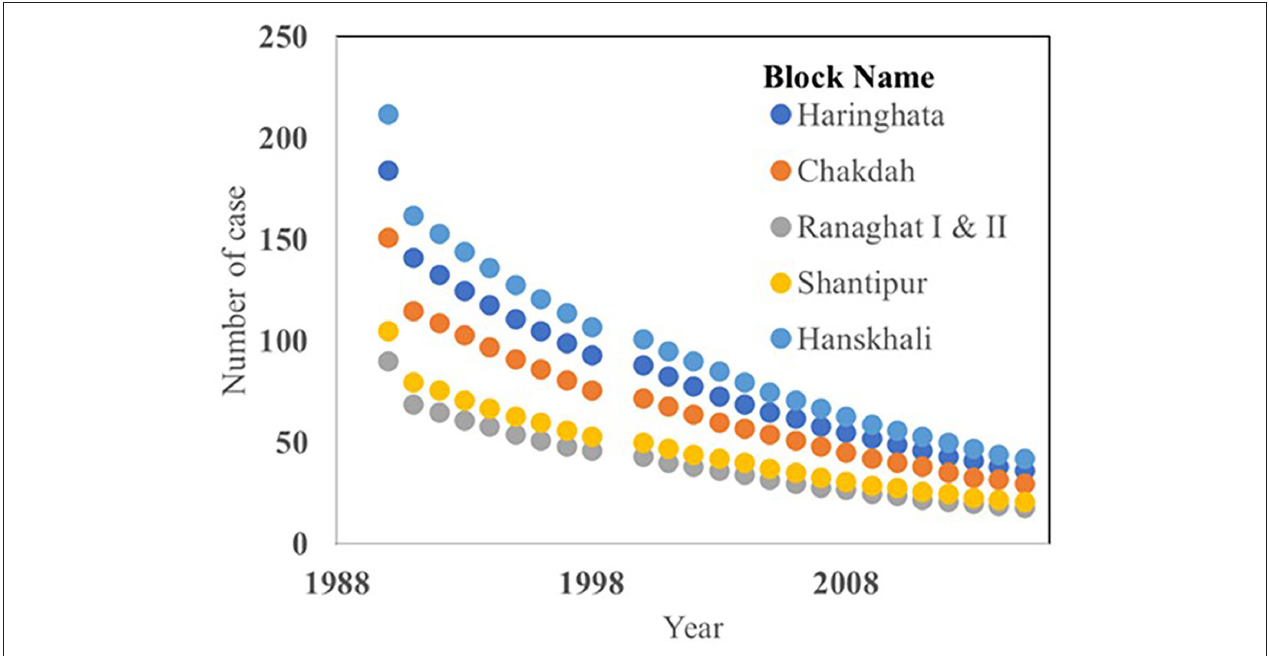
FIGURE 7 | Year-wise number of acute diarrhea cases in the study